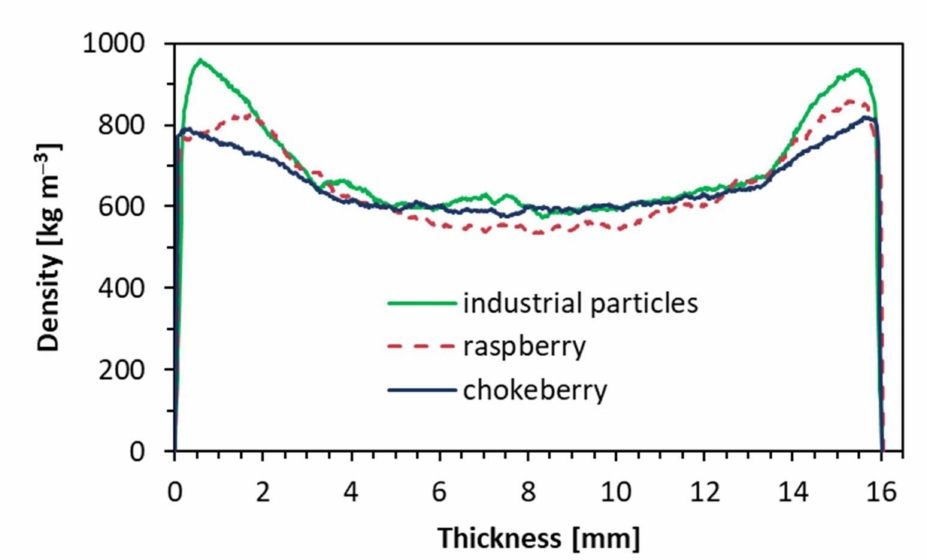
Figure 10. Density profiles of the tested